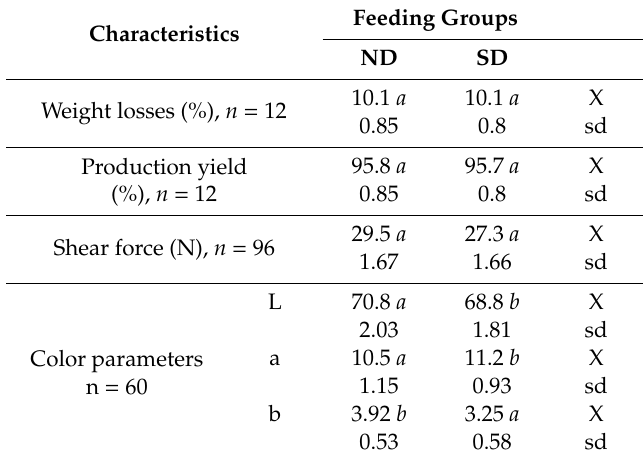
Table 3. Weight losses, yield of the process, shear force and color parameters measurement.